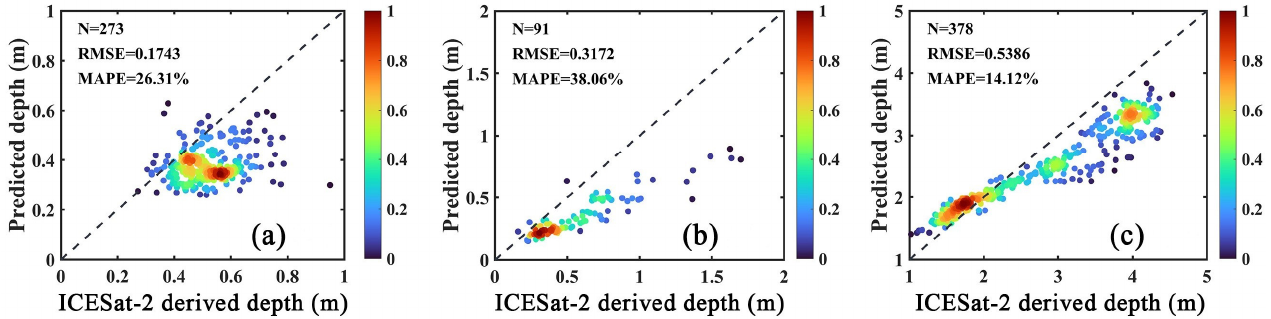
Figure 13. The density scatter plots between the ICESat-2 derived depth and the predicted depth from our depth retrieval model for three regions: ( a ) CP; ( b ) XC; ( c ) HG. The dotted line is the 1:1 line, and the color of the dots represents the density.